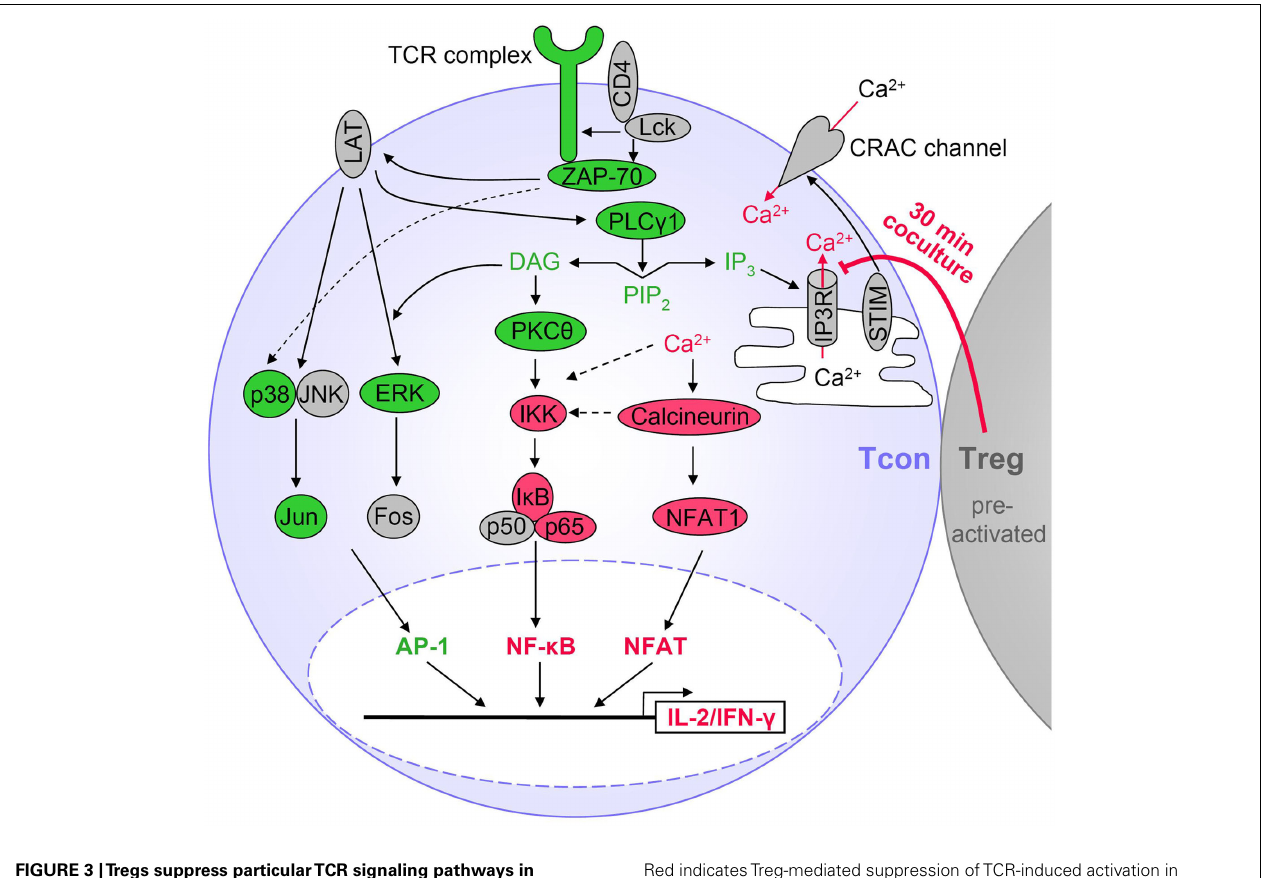
FIGURE 3 |Tregs suppress particularTCR signaling pathways in Tcons. ActivatedTregs rapidly suppress cytokine expression inTcons via inhibition of Ca 2 + signals and consequently reduced NF- κ B and NFAT activation. Suppression byTregs requires at least 30min of coculture, is favored by cell contact and sustained afterTreg removal.